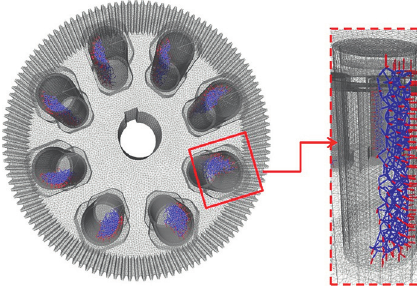
Figure 6: Force chain transfer in gear-particle transmission system.